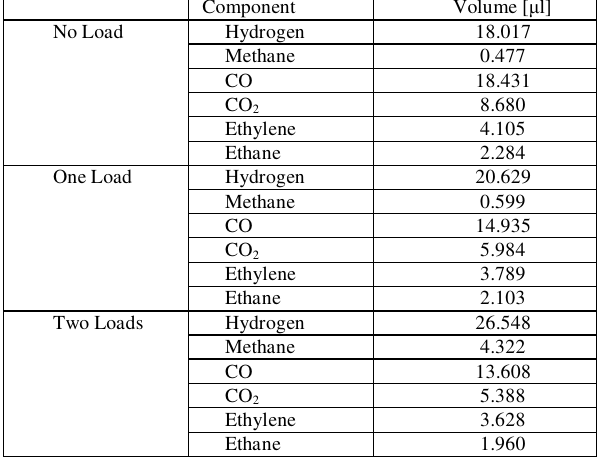
Table 4. Definition of the proportion of syngas components [13]